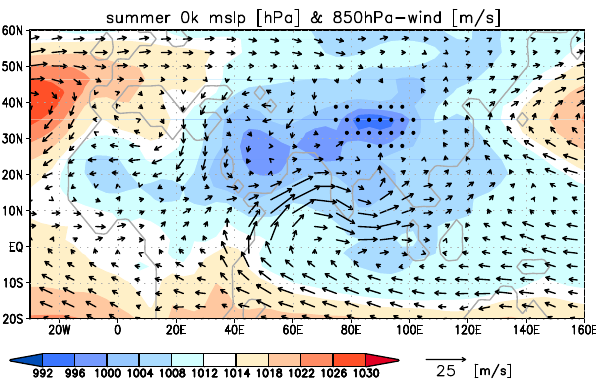
Fig. A3. Summer mean sea level pressure (shaded, [hPa]) and wind in 850hPa (vector, [m/s]) as simulated by the atmosphere-only run for present-day orbital